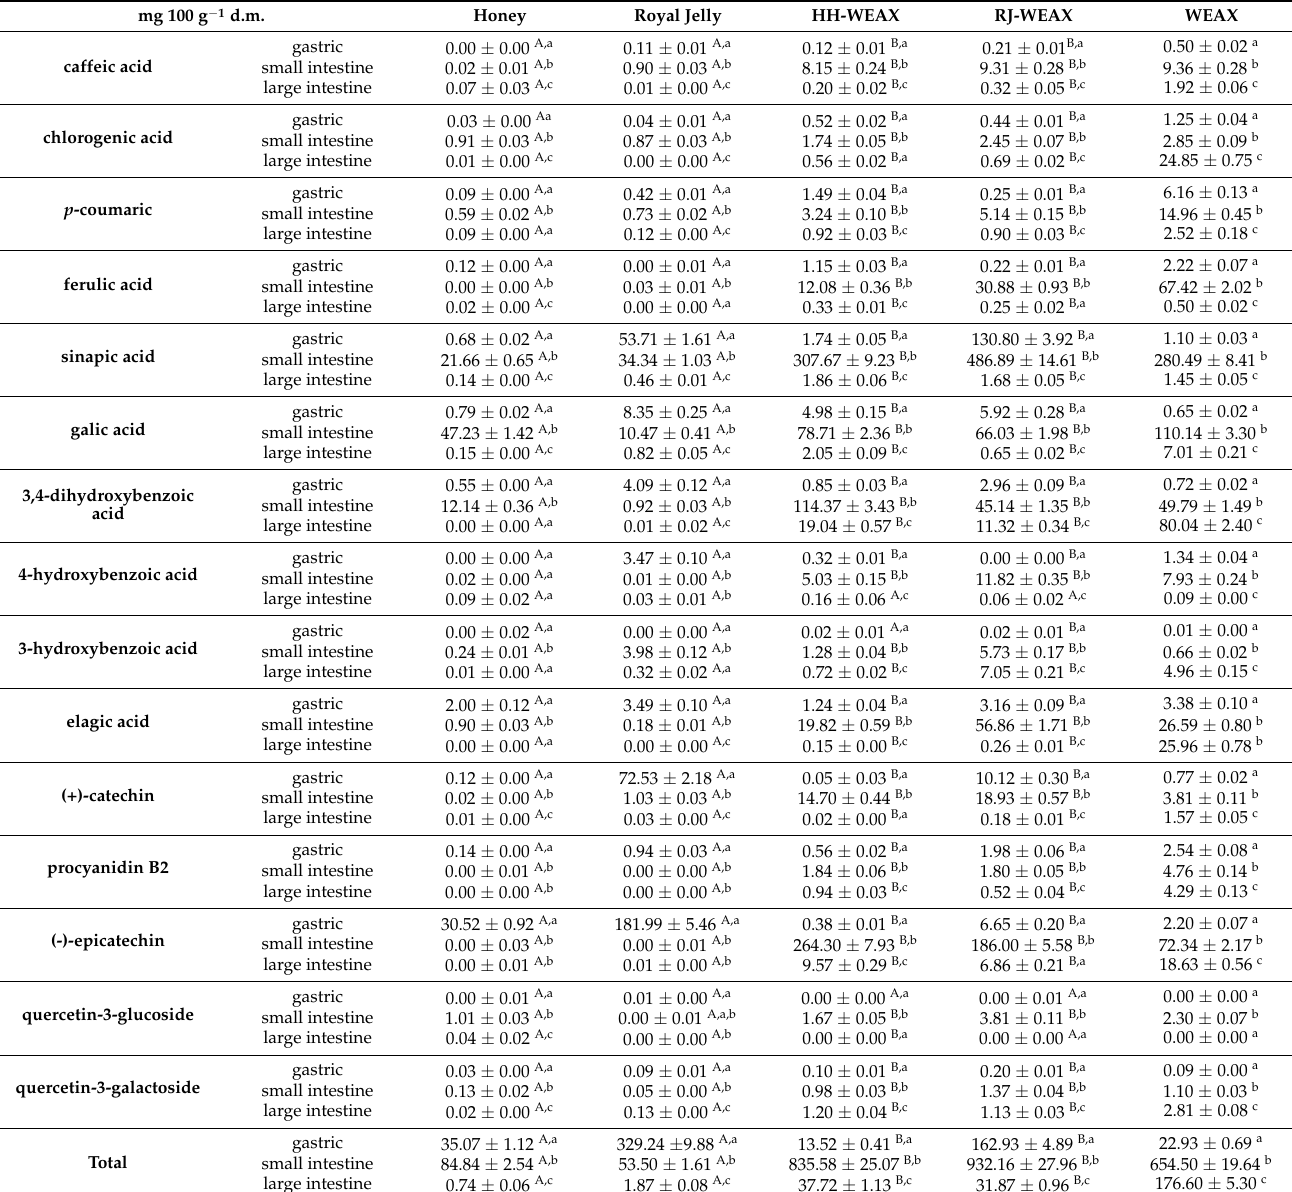
Table 1. Phenolic compounds profile during in vitro